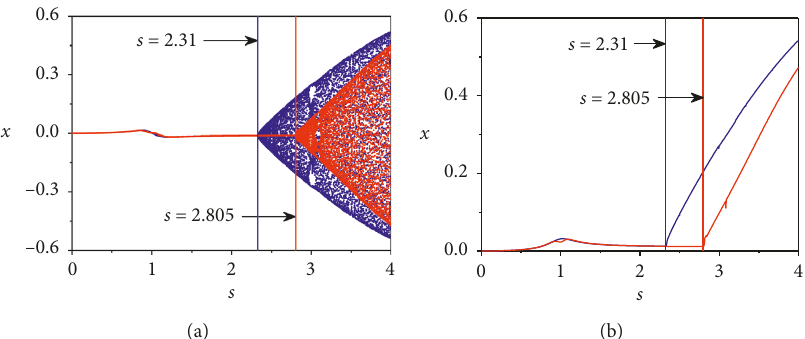
Figure 6: (a) The bifurcation diagram and (b) the amplitude-frequency response curve of the rotor/seal system in the x coordinate.